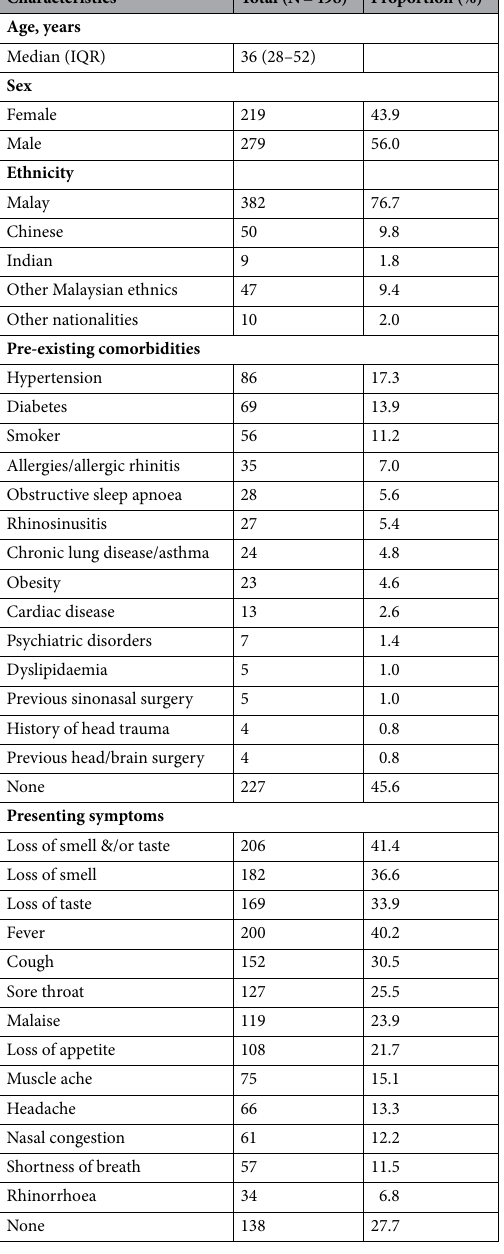
Table 1. Demographic and clinical characteristics of COVID-19 patients assessed for olfactory & taste